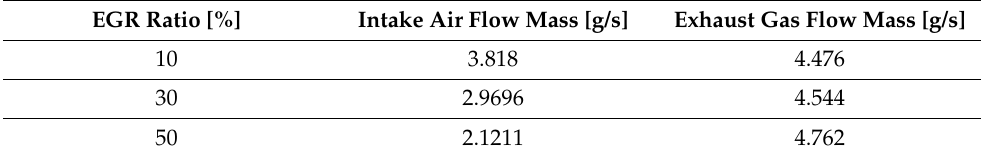
Table 4. Input parameters of the HCCI engine influenced by the EGR